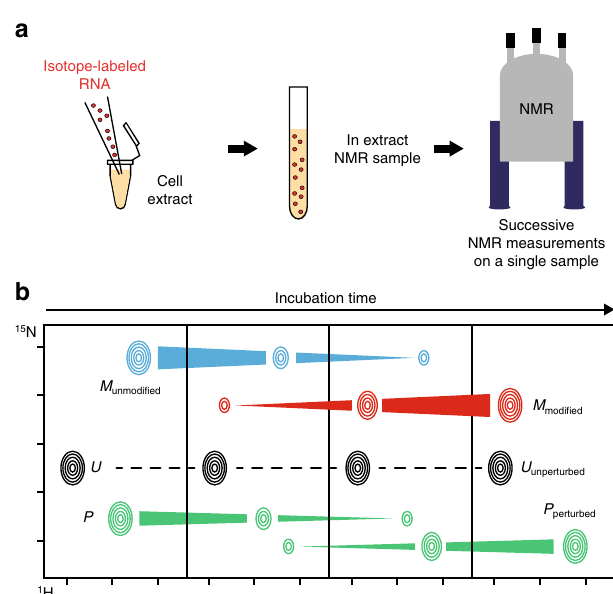
Fig. 1 Schematic description of the method. a An isotope-labeled RNA (represented as red dots) is introduced in cell extracts in an NMR tube to yield an in extract NMR sample. Successive NMR measurements on a single sample incubated directly in the NMR spectrometer can then be performed. b RNA modi fi cations are monitored on the RNA imino signals with 2D ( 1 H, 15 N) NMR spectra in a time-resolved fashion. Modi fi cations cause the progressive disappearance of imino signals from unmodi fi ed nucleotides (signal M disappearing in blue) and the correlated appearance of new imino signals from modi fi ed nucleotide (signal M appearing in red). Modi fi cations also cause disappearance and correlated appearance of imino signals of nearby nucleotides (signal P in green). Nucleotides far away from modi fi cation sites have unperturbed imino signals over time (signal U in